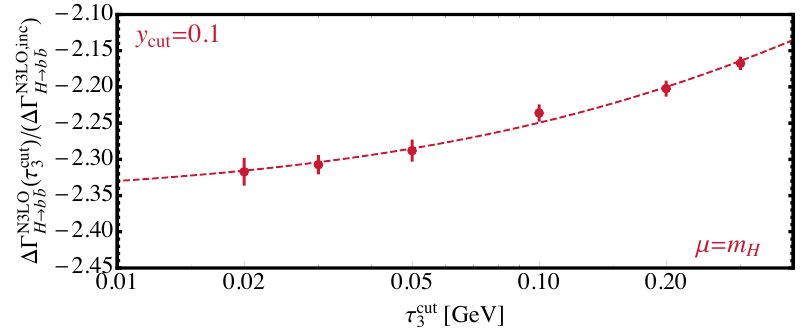
Figure 6 . The dependence of the N 3 LO coe(cid:14)cient (in units of the inclusive N 3 LO coe(cid:14)cient (cid:1)(cid:0) N3LO ) on the parameter (cid:28) cut 3 H ! bb